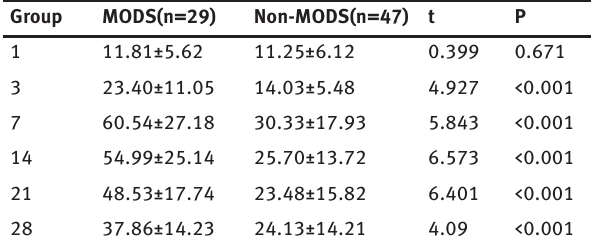
Table 2: The serum neopterin comparison between MODS and non- MODS groups in PBDs 1 to 28( sx ±